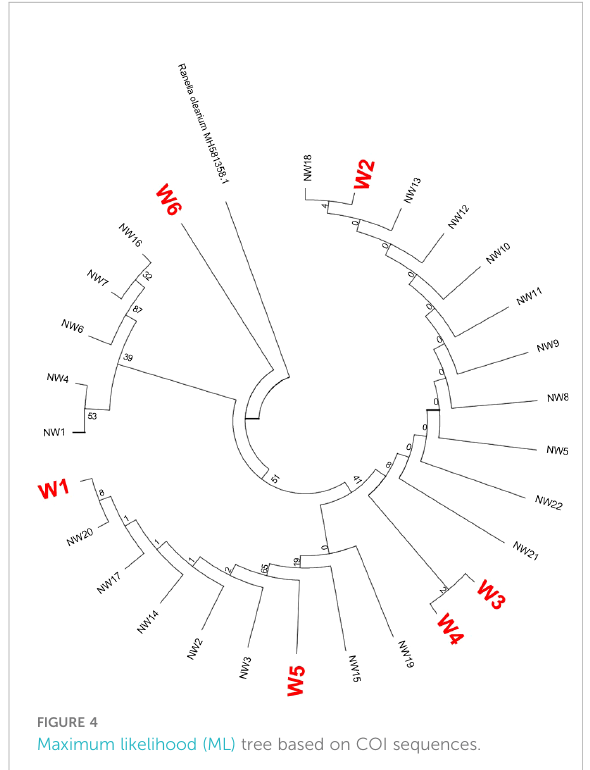
FIGURE 4 Maximum likelihood (ML) tree based on COI